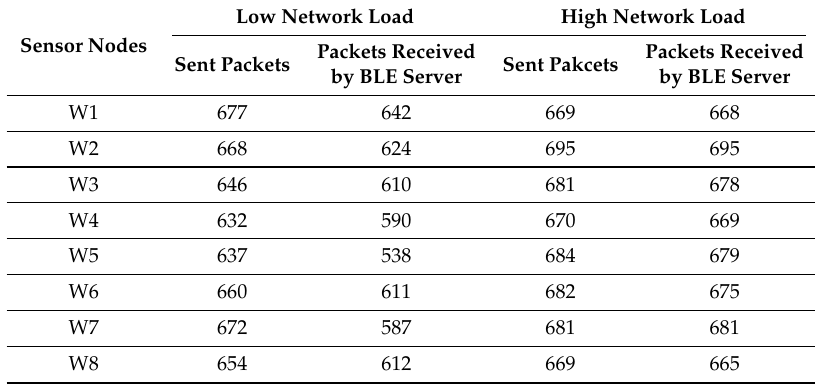
Table 11. Number of packets sent by each sensor node and received by BLE server, for each Waspmote device configuration in Individual Mesh with CSR devices retransmit each packet